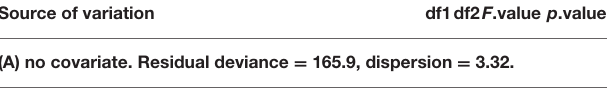
TABLE 6 | ANOVAs of crop identity, herbicide, and covariate effects on population sex ratio using 2018 data. Source of